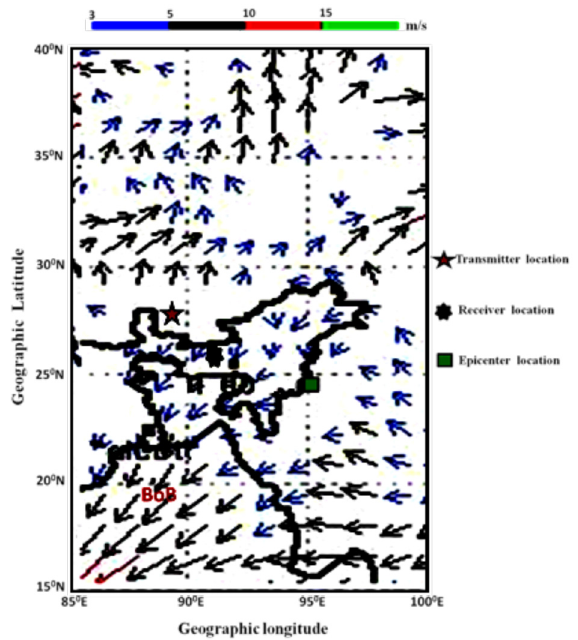
Figure 14. Speed (m/s) and direction of winds prevailing in the North East (NE) part of India during the month of January, as ob- tained from a mesoscale model VARSHA. Note that the North East- erly (NE) wind is most significant during this season. The position of transmitter, GU and the epicenter are marked in the